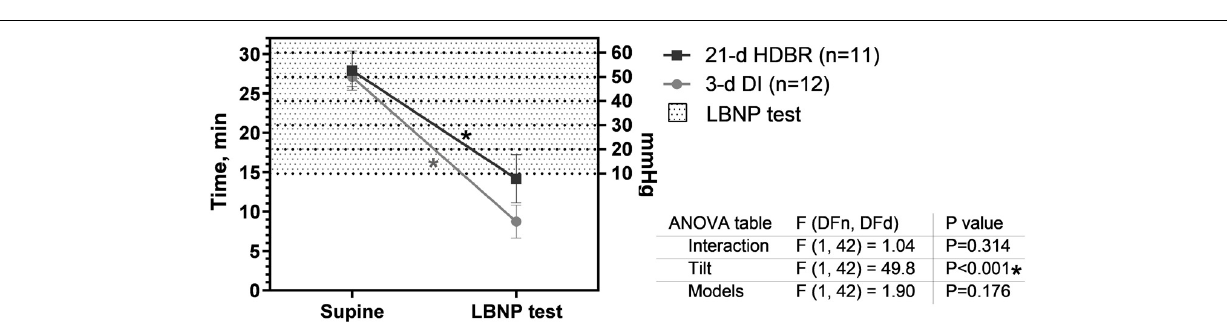
FIGURE 7 | Orthostatic tolerance time before and after the 21-day head-down bed rest (HDBR) and 3-day dry immersion (DI). Data are the mean ± SEM. * p < 0.05 vs. before